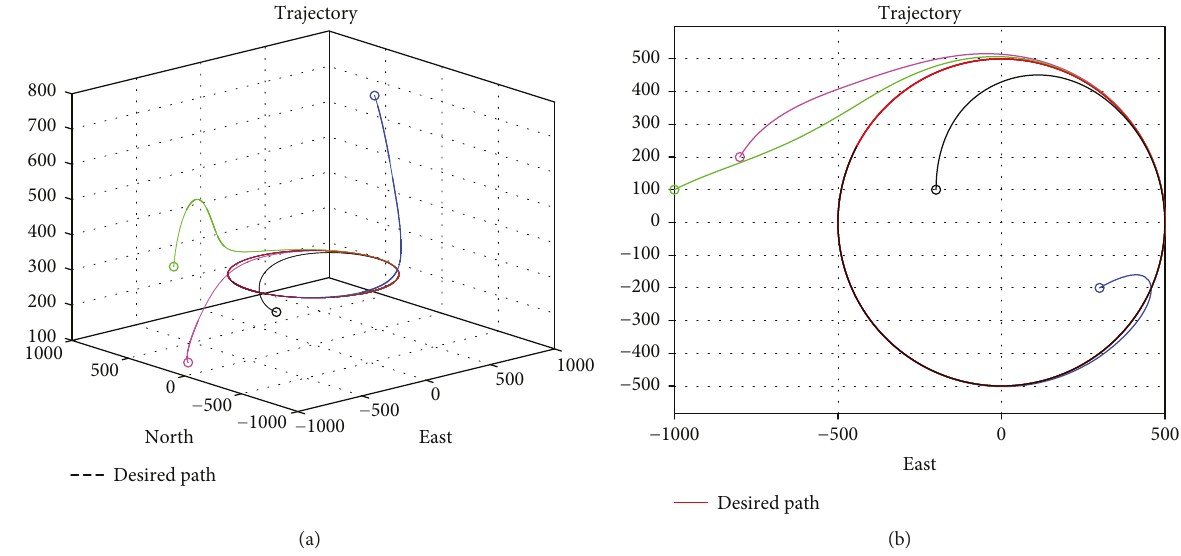
Figure 12: Circular path following. (a) Three-dimensional view, (b) planar view. Cross-track error